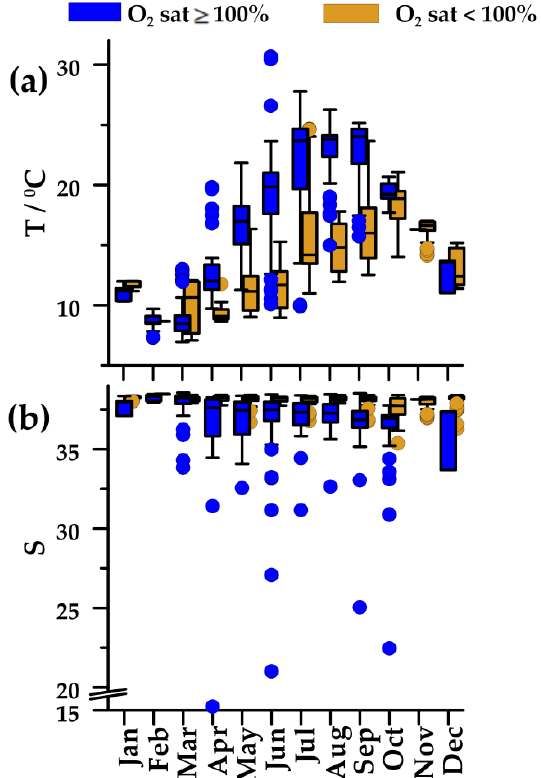
Figure 3. Annual cycles of ( a ) temperature (T), and ( b ) salinity (S) in oxygen ‐ saturated (blue squares) and oxygen ‐ undersaturated waters (golden squares) in the Northern Adriatic during 2004–2013. Plot characteristics are reported in Figure 2.